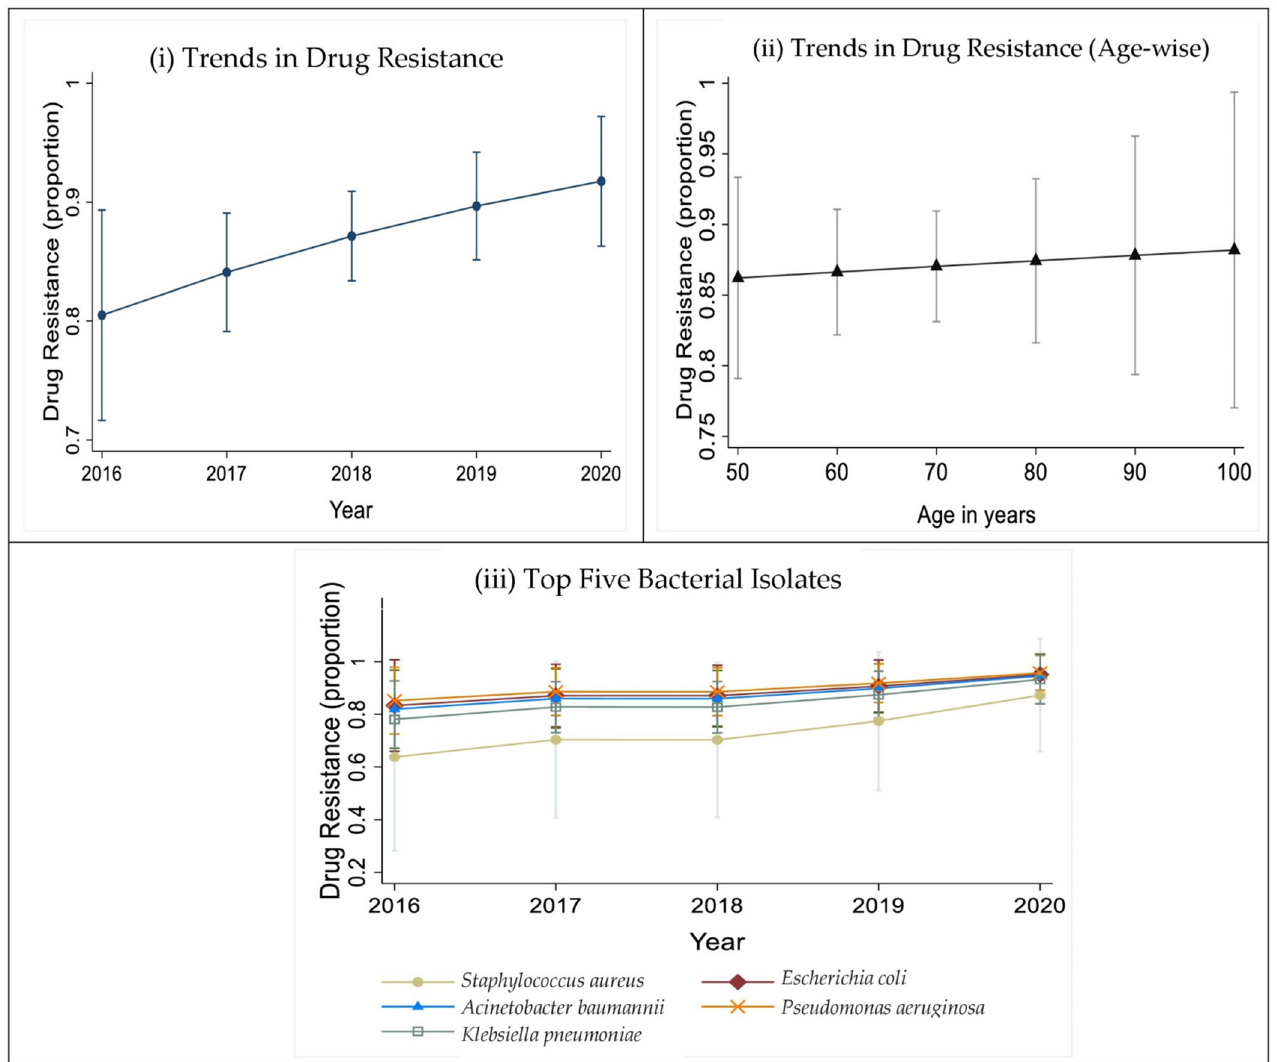
Figure 3. Trends in the overall drug resistance (DR, MDR, XDR), a gradual increase in the prevalence of drug resistance was observed, from the year 2016 to 2020 ( i ); Trends in the overall drug resistance (DR, MDR, XDR) adjusted with age ( ii ); Trends in the overall drug resistance of the top five bacterial organisms ( Acinetobacter baumannii , Escherichia coli , Klebsiella pneumoniae , Pseudomonas aeruginosa , and Staphylococcus aureus , from the year 2016 to 2020 ( iii ). (Note: Proportion 0.1 = 10%, 1 = 100%; No Escherichia coli and Staphylococcus aureus were isolated in 2020, which was due to the COVID-19 pandemic, which led to fewer patient admissions and in turn fewer culture-positive